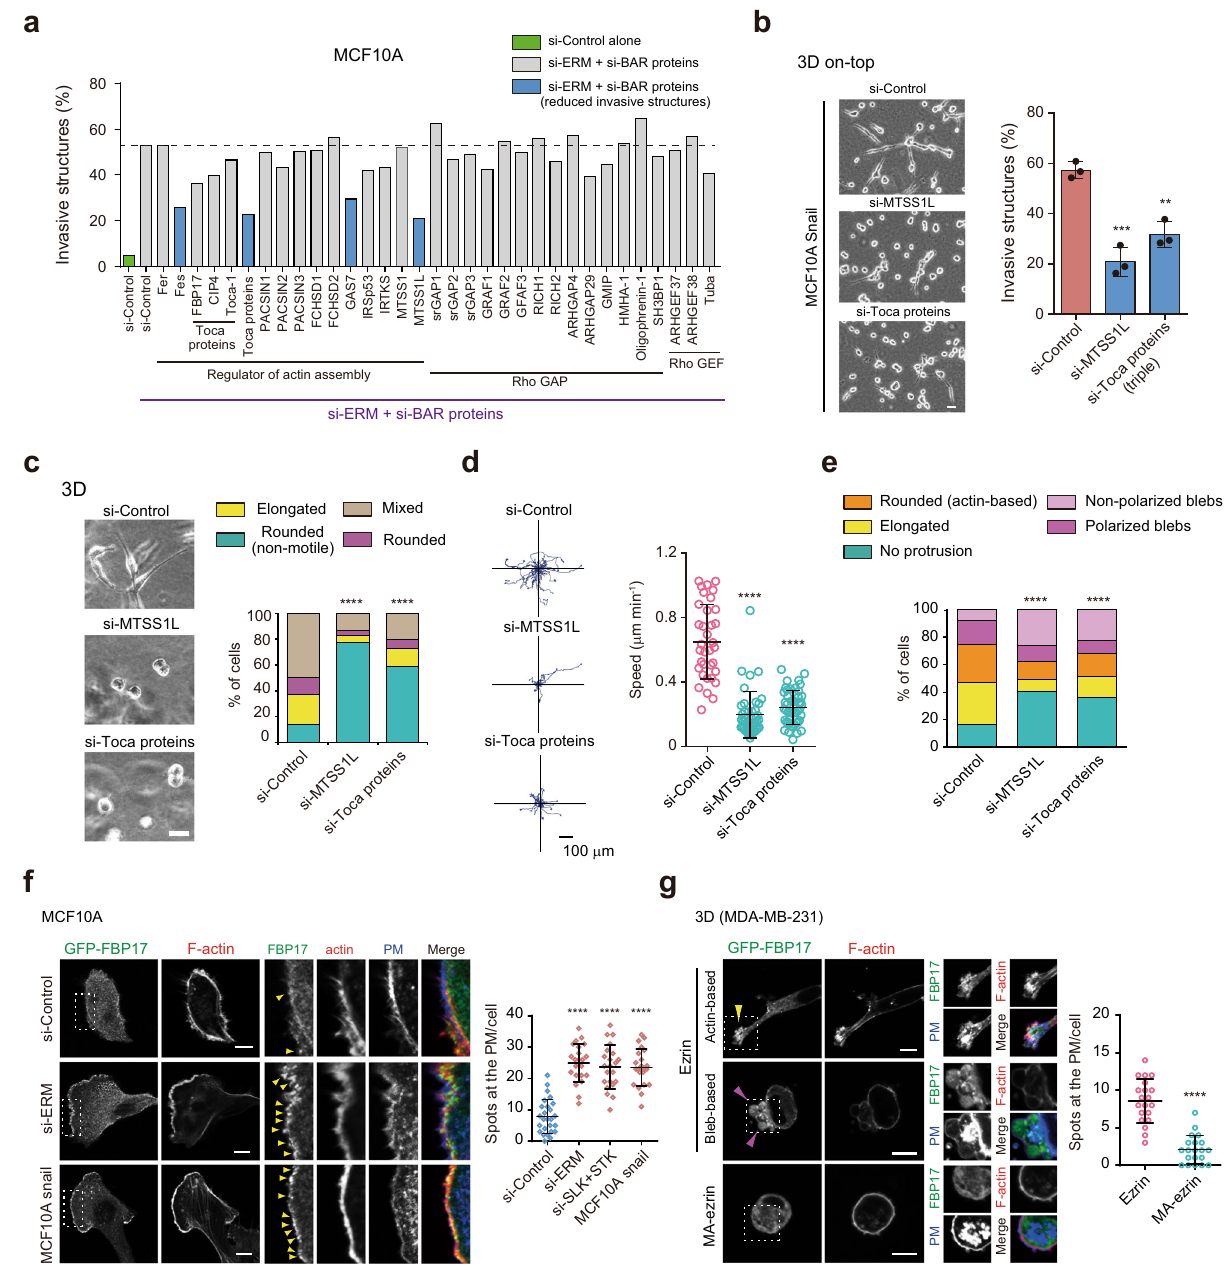
Fig. 5 Homeostatic PM tension suppresses cancer cell migration by counteracting BAR proteins. a Fraction of MCF10A spheroids with invasive structures grown in 3D on-top culture treated with the indicated RNAi. Control siRNA alone and siRNAs targeting BAR proteins that reduce invasive structures induced by ERM deletion are shown in green and blue, respectively. Data are mean of two independent experiments with at least 50 cells per experiment. b Left, representative images of the indicated cells in 3D on-top culture. Right, fraction of the invasive structures of the indicated cells. Data are mean ± SD of three independent experiments with at least 200 cells per experiment. Scale bar, 20 µ m. ** P = 0.002; *** P = 0.0007. c Phase-contrast images of MDA-MB-231 cells treated with the indicated RNAi in 3D. Scale bar, 20 µ m. Right, quanti fi cation of 3D migration phenotypes of n = 153 (si-Control), n = 150 (si-MTSS1L), and n = 155 (si-Toca proteins) cells from three independent experiments. d Trajectories of cell centroids of the indicated cells tracked in c for 8 h. Right, the average speed of one cell over the course of 8 h. n = 35 (si-Control), n = 43 (si-MTSS1L), and n = 46 (si-Toca proteins) cells pooled from three independent experiments. Mean ± SD. e Quanti fi cation of protrusions of the indicated cells in 3D. n = 151 (si-Control), n = 132 (si-MTSS1L), and n = 138 (si-Toca proteins) from three independent experiments (see also Supplementary Fig. 5e). f Confocal images of the indicated cells expressing GFP-FBP17 stained with phalloidin and WGA. Yellow arrowheads indicate GFP-FBP17 spots at the PM. Scale bars, 10 µ m. Right, quanti fi cation of GFP-FBP17 puncta of n = 26 (si-Control), n = 22 (si-ERM), n = 22 (si-SLK + STK10), and n = 22 (Snail-expressing cells) cells pooled from three independent experiments. g Confocal images of the indicated cells stained with phalloidin and WGA in 3D. Yellow and magenta arrowheads indicate FBP17 accumulation at actin- and bleb-based protrusions, respectively. Scale bars, 10 µ m. Right, quanti fi cation of GFP-FBP17 puncta of n = 20 (ezrin) and n = 20 (MA-ezrin) cells pooled from three independent experiments. All data, except for a , were expressed as mean ± SD. Signi fi cance tested using the two-tailed Student ’ s t -test ( b , f , g ), two-tailed Mann – Whitney test ( d ), and chi-square test ( c , e ). **** P < 0.0001.